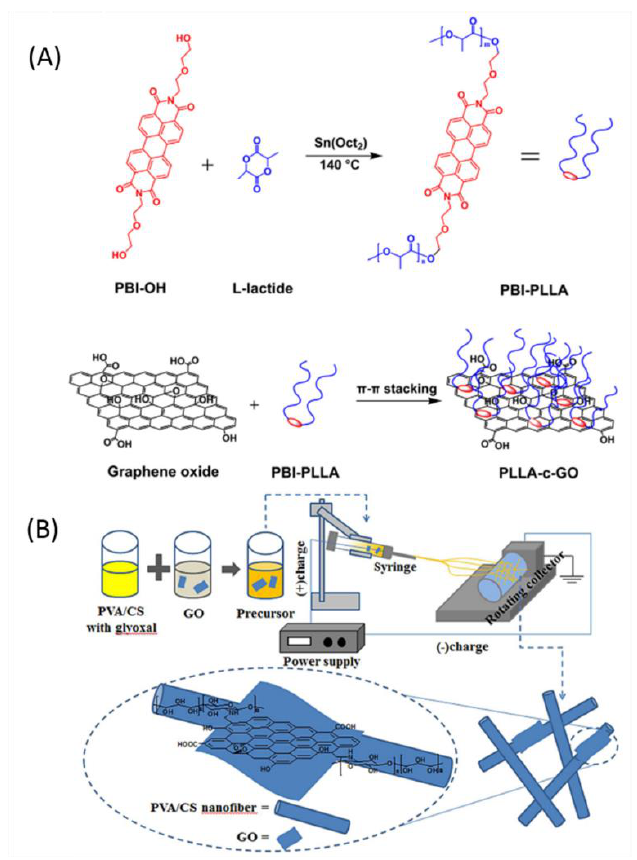
Figure 4. ( A ) Schematic illustration of the preparation of PLLA-c-GO from PLLA and GO. Reproduced from Reference [188], with permission from Elsevier, 2017. ( B ) Procedure for the fabrication of PVA / CS nanofibers with self-assembled GO nanosheets. Reproduced from Reference [189], with permission from Elsevier, 2014.